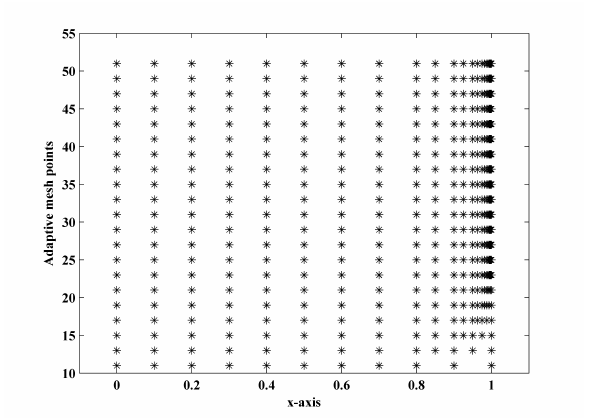
Fig. 7: Adaptive mesh generation for example 5.3 with ε = 2 −30 , δ = 0.1 , η = 0.2 , M=10(initially) and N=20.